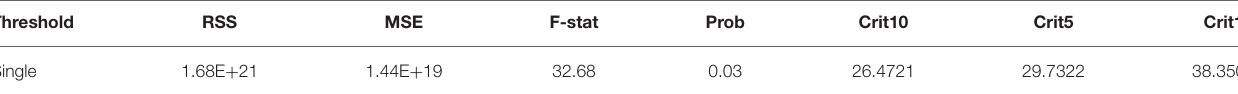
TABLE 2 | Threshold effect test of short-term liabilities. Threshold